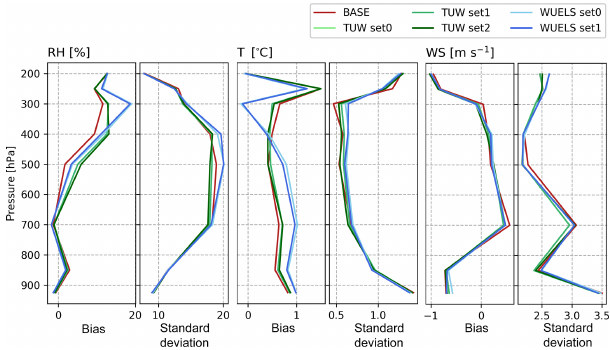
Figure 14. From the right, statistics (bias, standard deviation) for relative humidity (RH), temperature ( T ) and wind speed (WS) base forecast and model fed with TUW (set0, set1, set2) and WUELS (set0, set1) data when compared with radiosonde measurement; comparison at assimilation time (6h since model